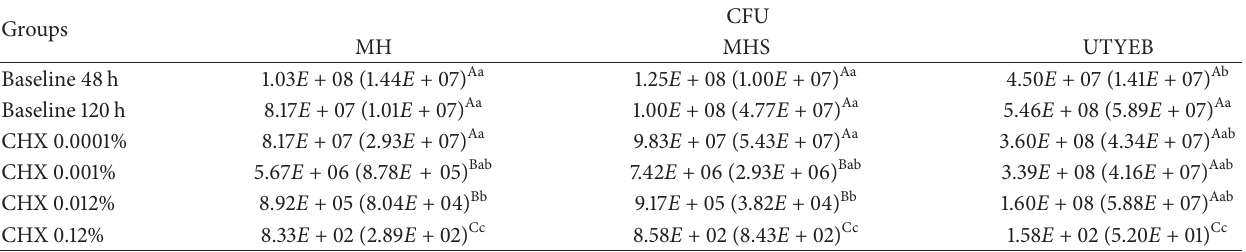
Table 2: % means and standard deviations of viable bacteria (CFU) in the biofilms growth according to the treatments. Groups